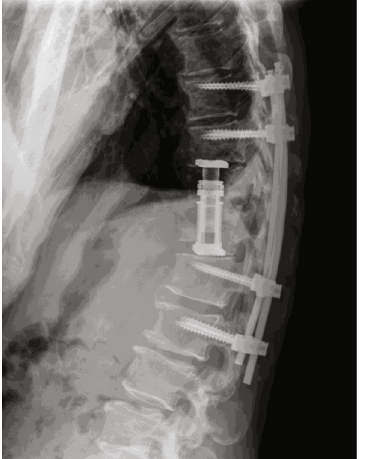
Figure 4: Lateral thoracic spine shows T9-L2 posterior pedicle screw and rod fi xation with T11 and T12 corpectomies with expandable intervertebral cage.